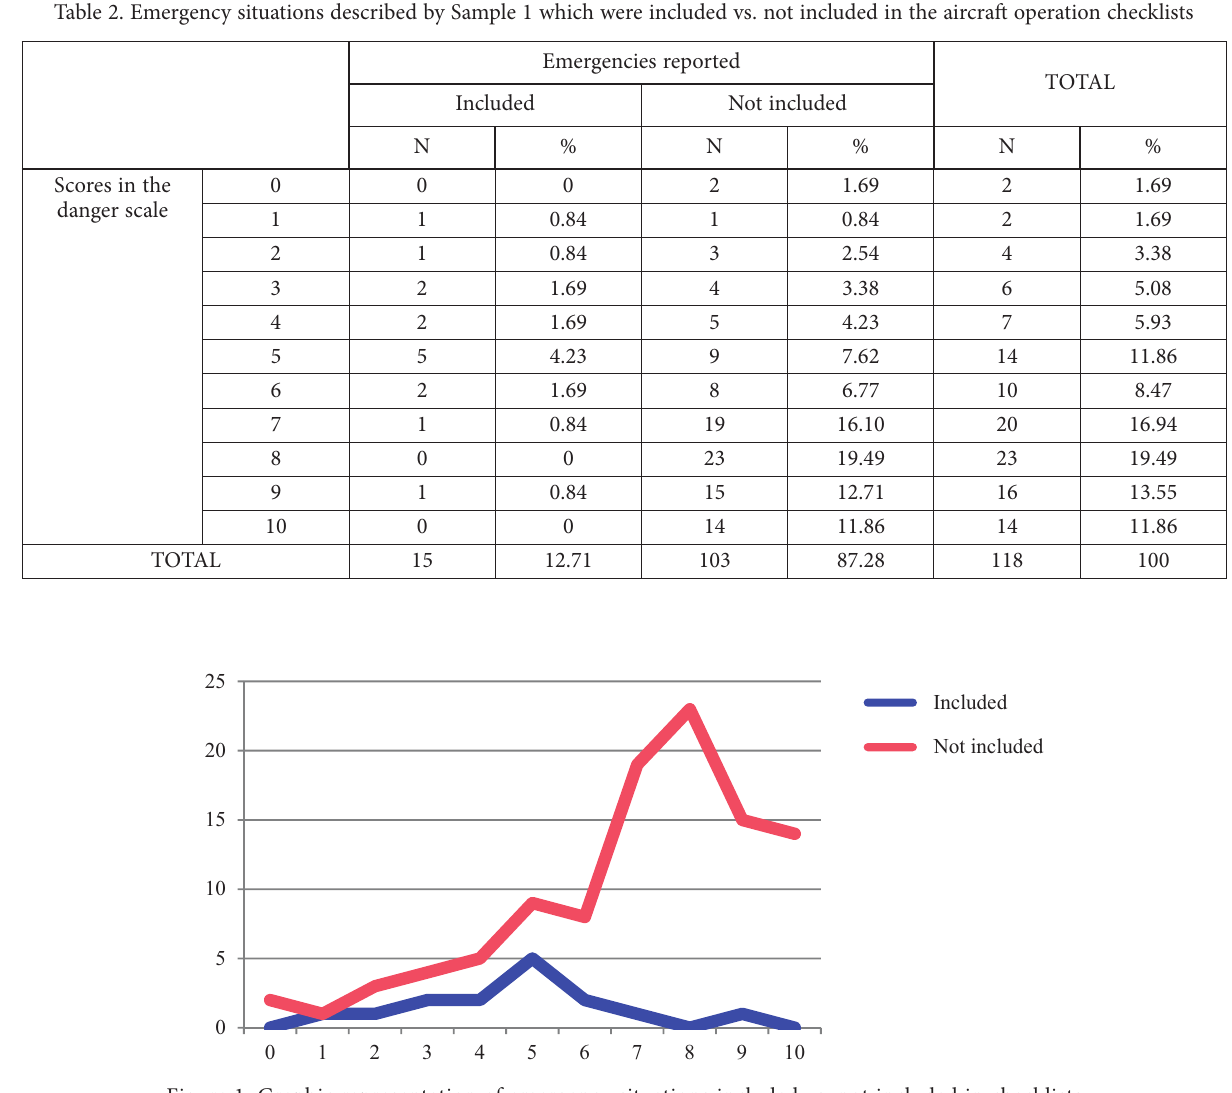
Figure 1. Graphic representation of emergency situations included vs. not included in